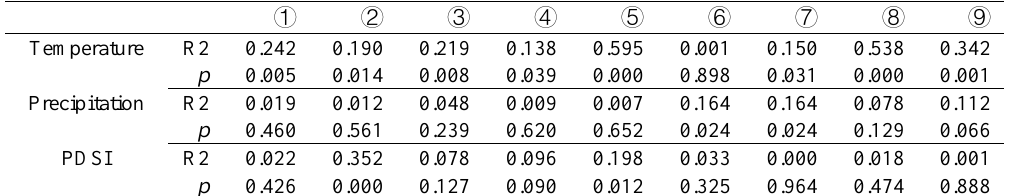
Table S4. The statistical report of climate change trend in terms of nine major crop zones. Where ① ~ ⑨ represent the Central Eur_Rus zone, East China zone, North America zone, South Australia zone, Southeast Latin America zone, West Latin America zone, Southwest Africa zone, Southwest Asia zone, and West Europe zone, respectively.